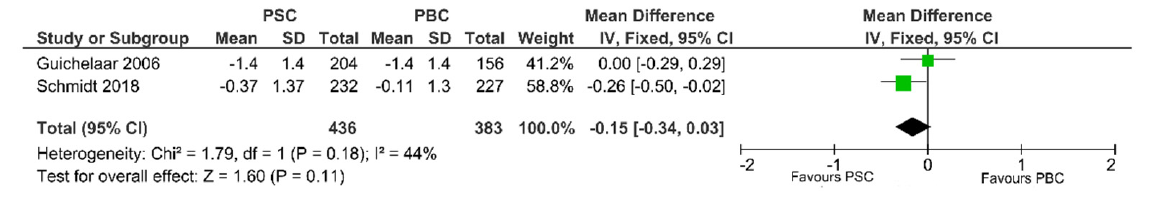
Figure 5. Forest plot assuming a fixed-effects model for Z-score PSC vs. PBC [30,33].